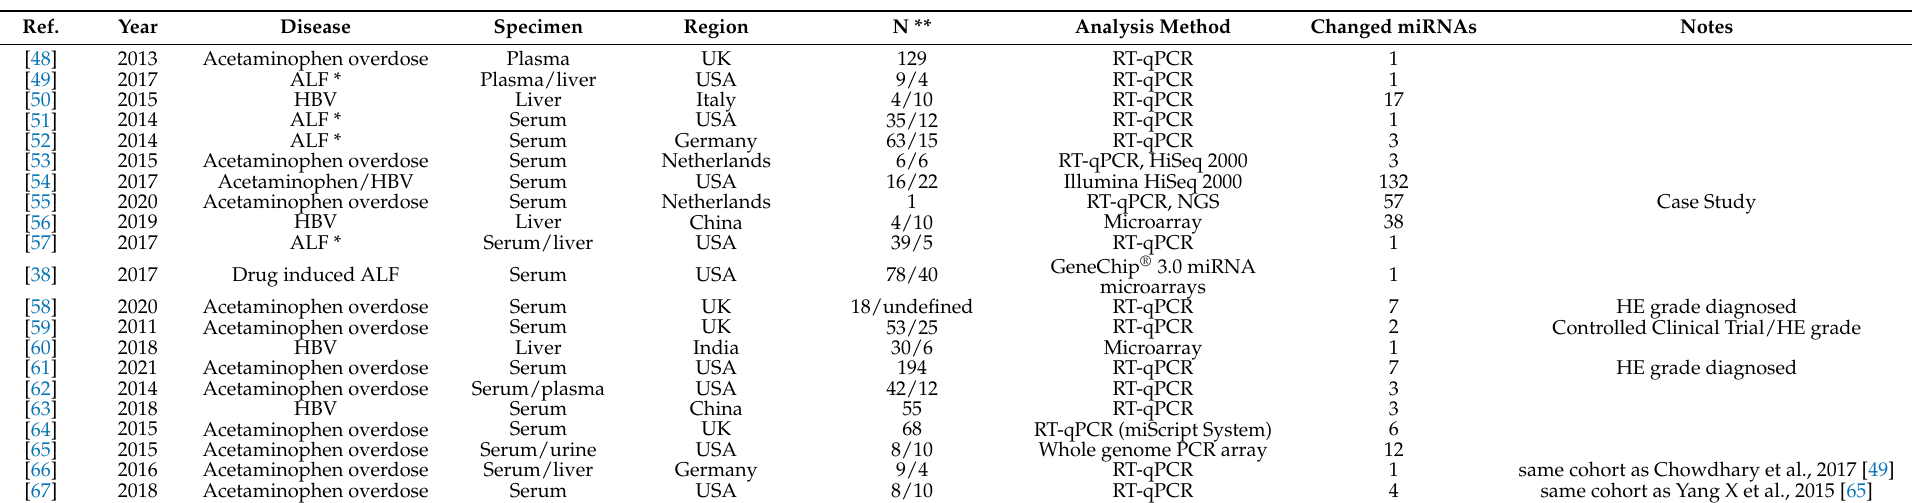
Table 2. Summary of the included